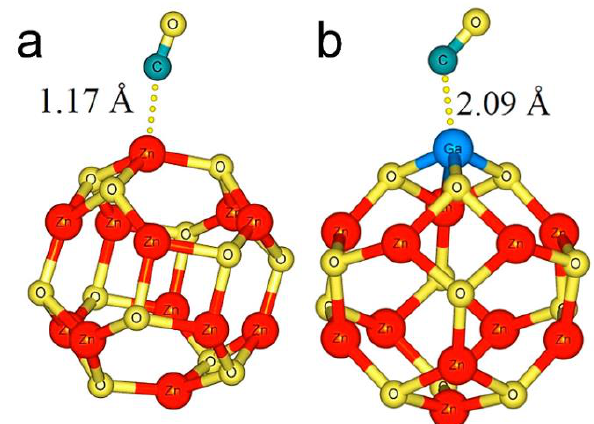
Figure 7. Optimized structures of CO adsorption on undoped Zn 12 O 12 ( a ) and Ga-doped Zn 11 O 12 ( b ) clusters. Obtained from reference [96].